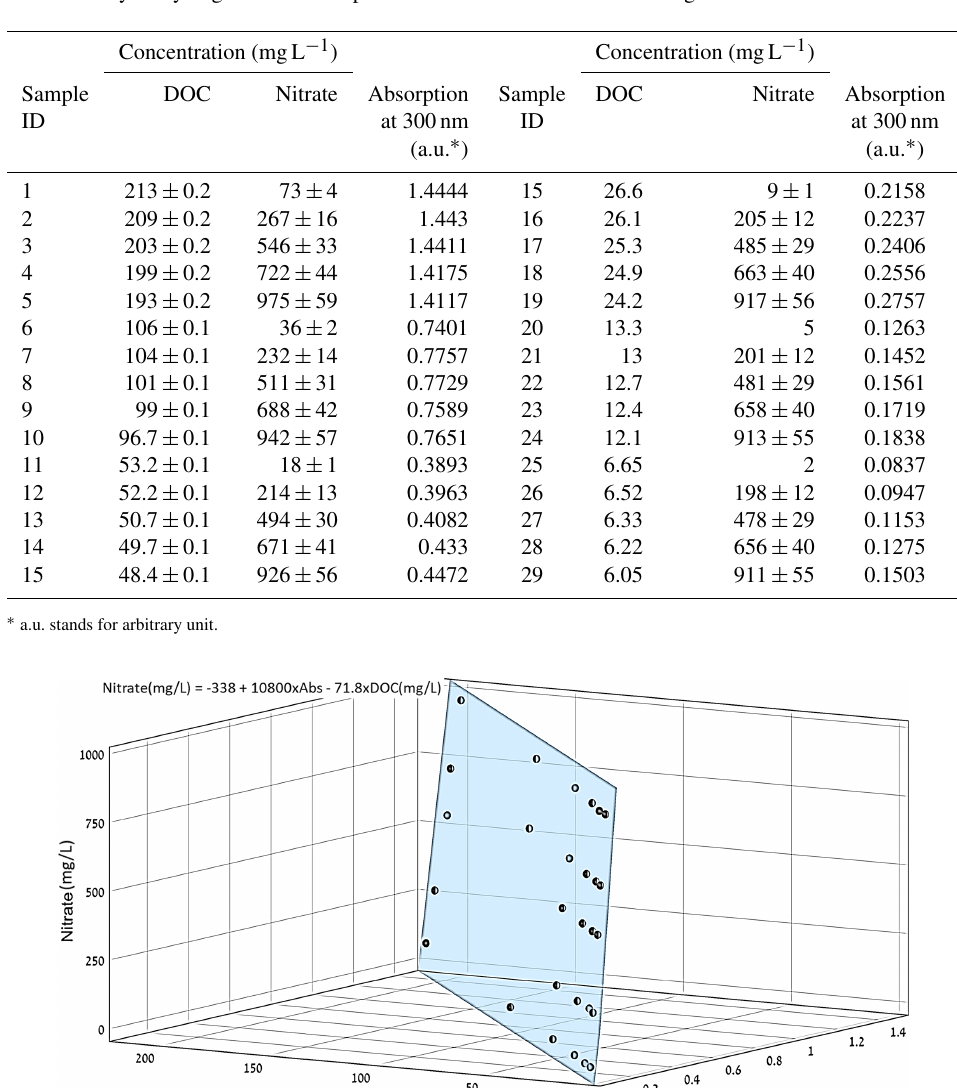
Table 2. Database obtained by analyzing the water samples extracted from the conventional greenhouse soil.